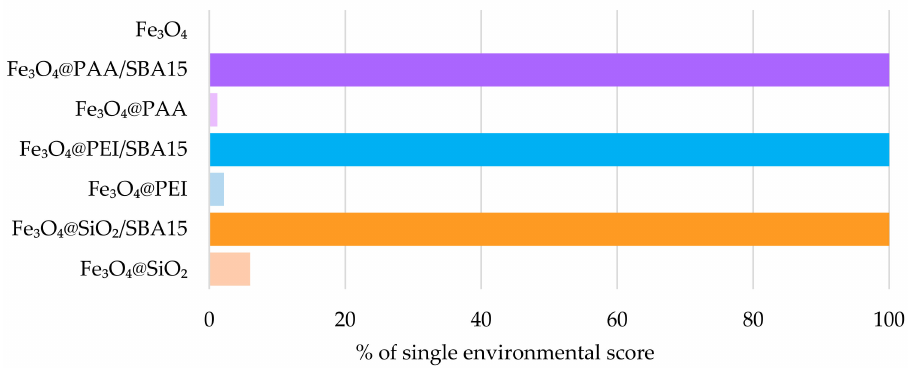
Figure 1. Benchmarking relative values of single environmental scores for the synthesis routes of magnetic